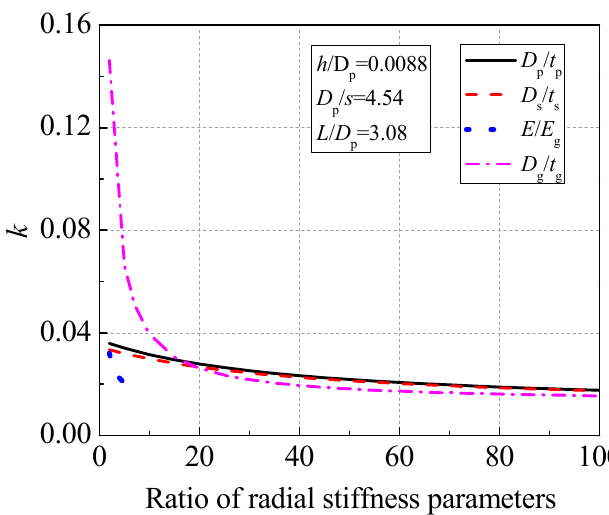
Figure 7. Relationship between radial stiffness factor ( k ) and D p / t p , D s / t s , E / E g , and D g / t g ratios.